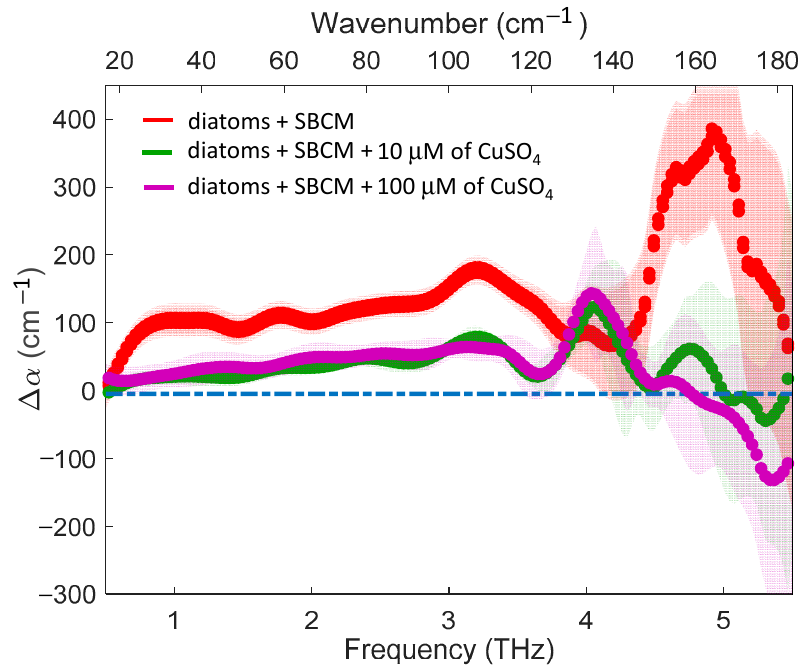
Figure 3. THz absorption variation as compared to the ‘baseline’ spectrum for diatom in SBCM, undoped (red line) and doped (green and purple lines). The dot-dashed blue line represents the zero level.